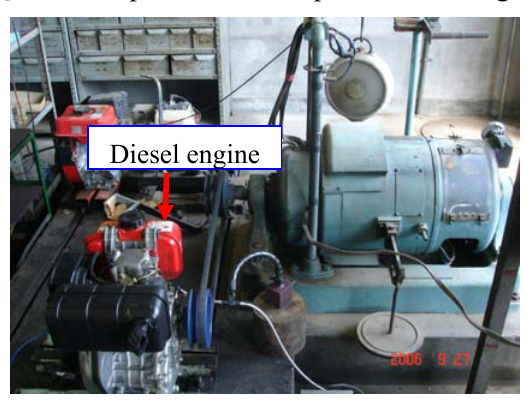
Figure 6. Experimental setup of a diesel engine.